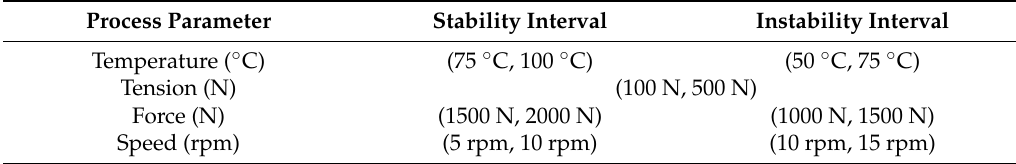
Table 3. Stability and instability interval for process parameters of the void content